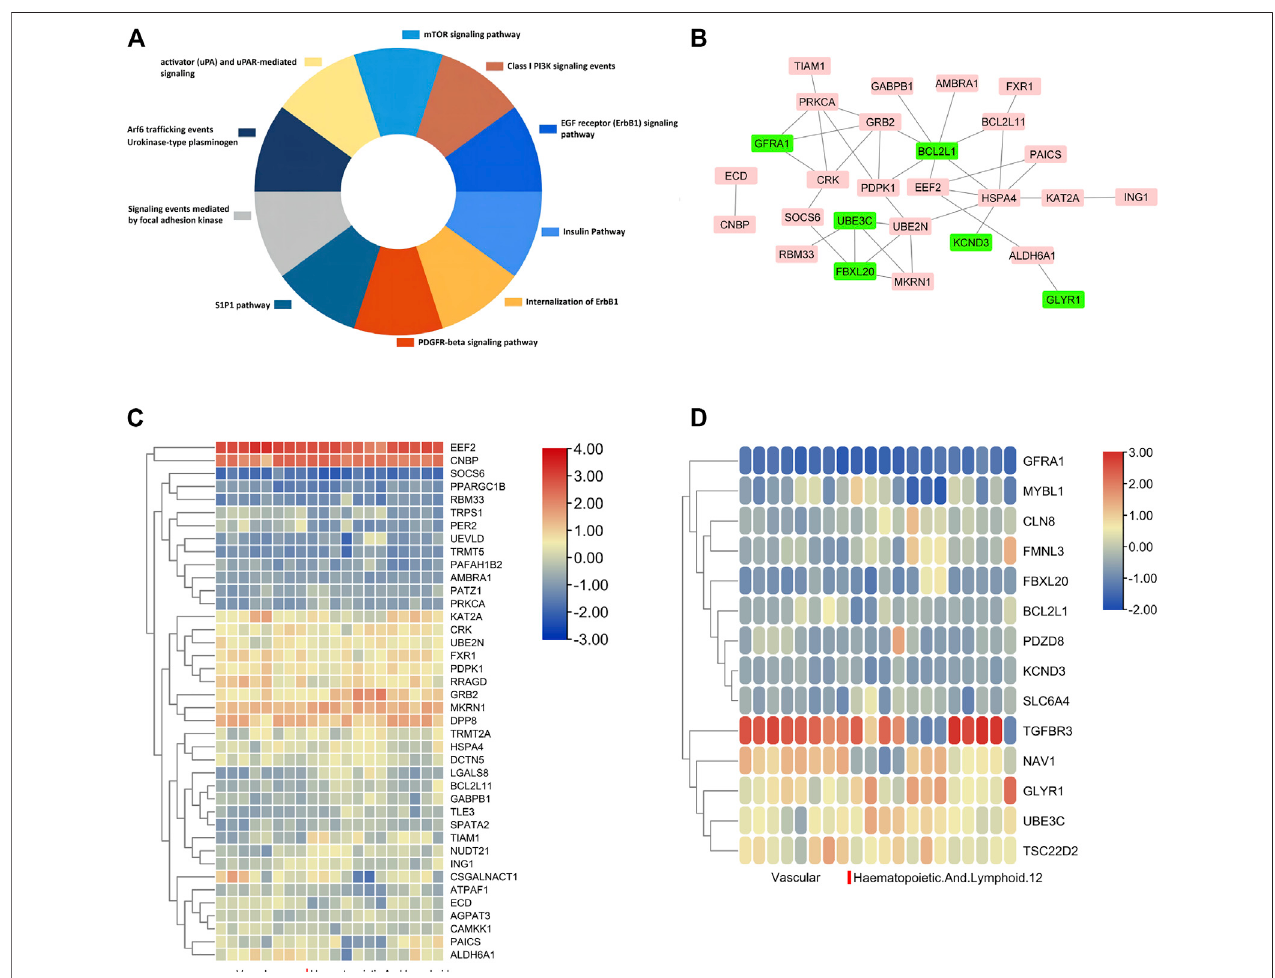
FIGURE5| Detailsforalltheoverlappedgenes. (A) ,KEGGandbiologicalprocessenrichmentanalysisofdualregulatedgenes,respectively. (B) ,PPInetworkofthe overlappeddual regulated genesincluding anup-regulated labelwithred colorand down-regulated geneswithgreencolor. (Cand D) ,Heatmap of43up-regulated (C) and 14 down-regulated genes (D) expressed in different tissues.